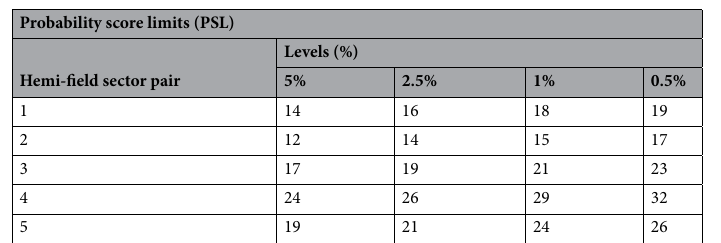
Table 2. The normative probability score limits (PSL) in four levels were determined for each hemi-field sector pair from the absolute up-down differences in probability scores obtained from the SRT using eye movement perimetry. SRT, saccadic reaction